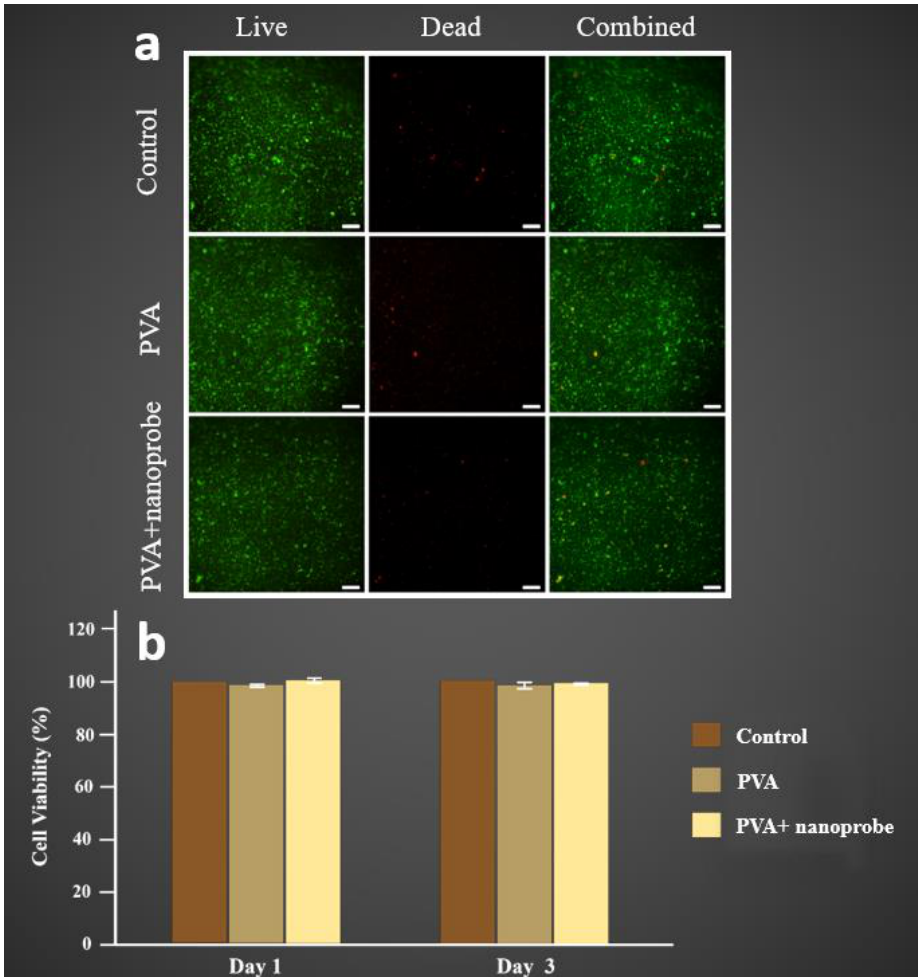
Figure 9. Cell viability: ( a ) live and dead staining of the cells cultured using media with conventional media (Control), PVA, and PVA + nanoprobe (Scale bars = 200 µm). ( b ) Cell viability assay (MTS) in A549 cells after 1 and 3 days. The data represent the means of three independent experiments.